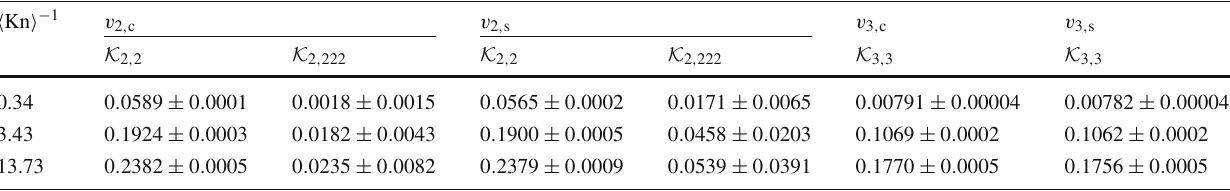
Table 7 Parameters of the fit functions for v 2 , c / s [nonlinear fit Eq. (5)] and v 3 , c / s [linear fit Eq. (4)] at b = 6 fm